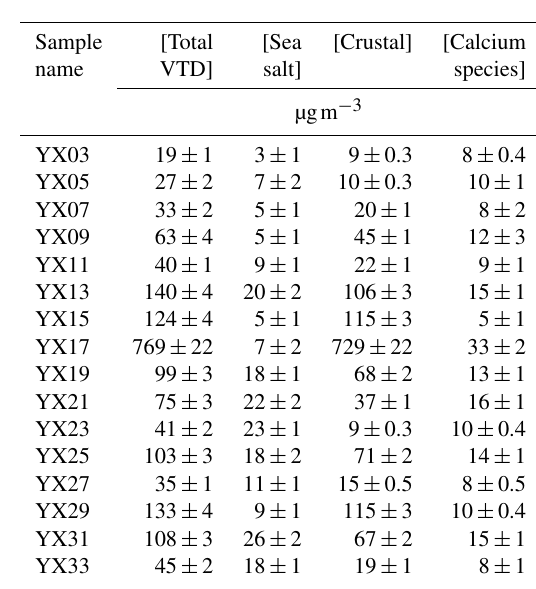
Table E1. VTD aerosol mass concentrations derived from chemical analyses with associated analytical uncertainties (95% confidence